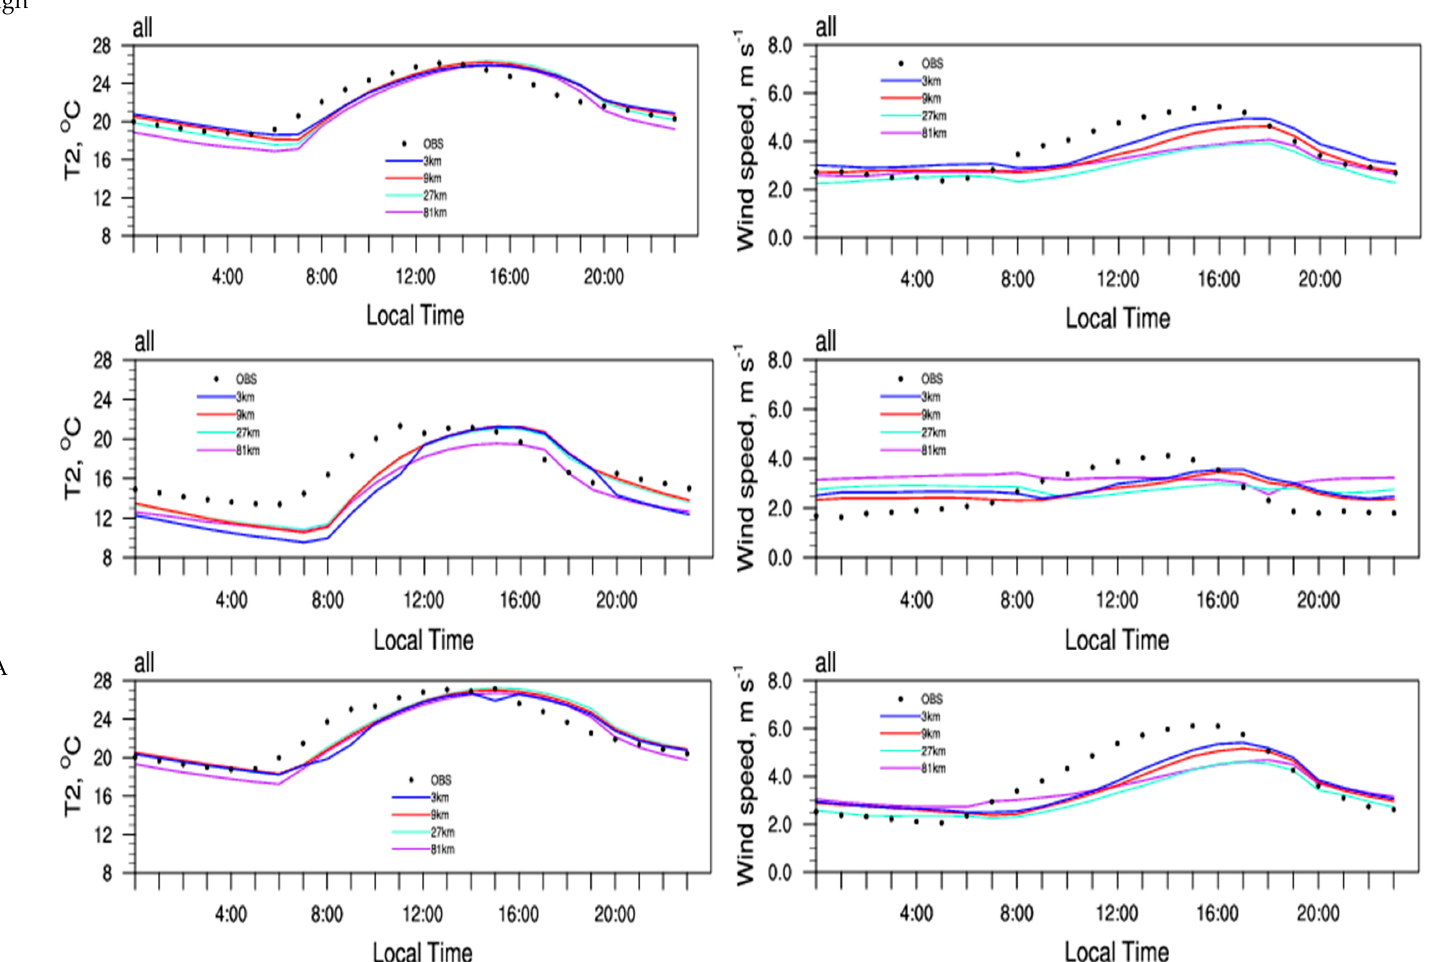
Figure 3. Observed and simulated diurnal profiles of temperature at 2-m (T2) and wind speed at 10-m (WS10) averaged over all meteorological monitoring stations maintained by the Bureau of Meteorology. All simulation results are based on WRF/Chem-ROMS.